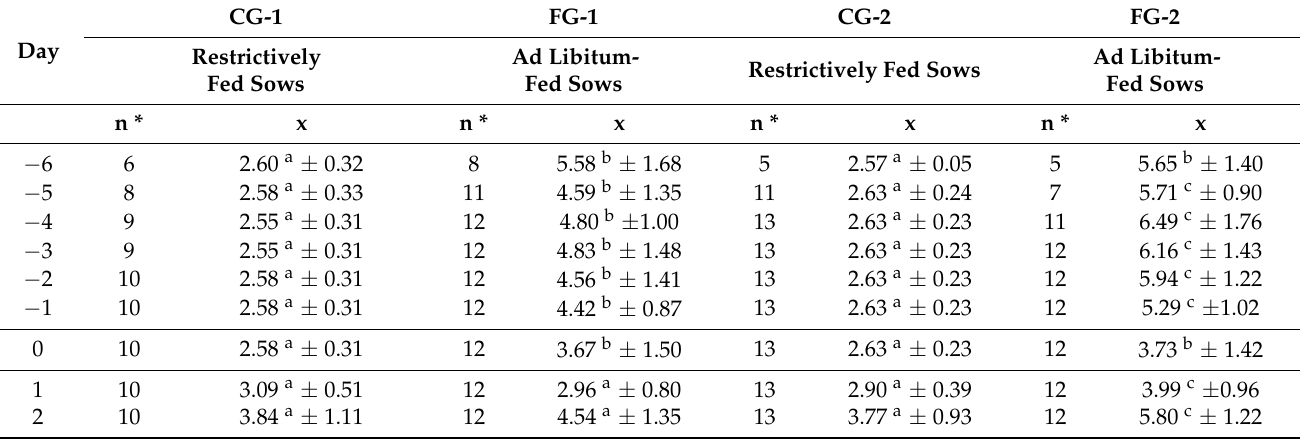
Table 5. Dry matter intake in kg/d and sow group in the peripartal period (d0 = parturition) in the four feeding